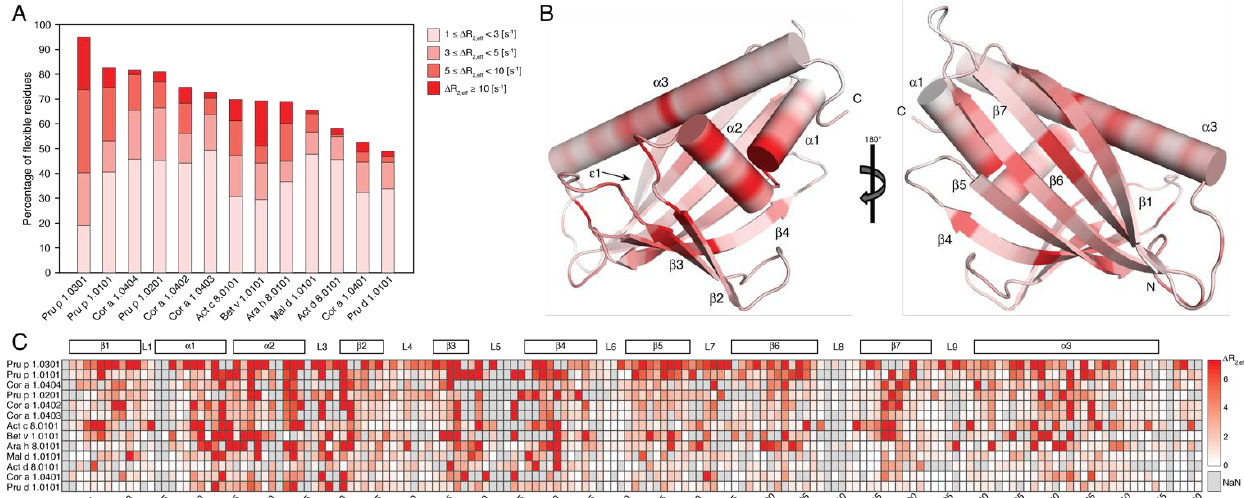
Figure 3. Structural flexibility of thirteen selected PR – 10 allergens. ( A ) Bar plot showing the percentages of residues with backbone amide 15 N relaxation-dispersion amplitudes ( ∆R 2,eff ) exceeding 1 s – 1 at 700 MHz. Bars are color-coded according to ranges of ∆R 2,eff values. ( B ) Residue-specific mean values of ∆R 2,eff over all thirteen PR – 10 proteins are plotted on the structure of Bet v 1.0101 (PDB: 4A88), color-coded from rigid (white) to flexible (red). ( C ) Heat map comparing backbone amide 15 N RD amplitudes vs. residue numbers, colored according to the shown gradient. Proteins are ordered as in ( A ). Grey squares indicate sequence positions for which experimental data are not available ( i ) due to gaps in a specific PR – 10 protein sequence, ( ii ) because of the resonance overlap of backbone amides, ( iii ) for prolines, or ( iv ) in cases where resonance assignments are not available.